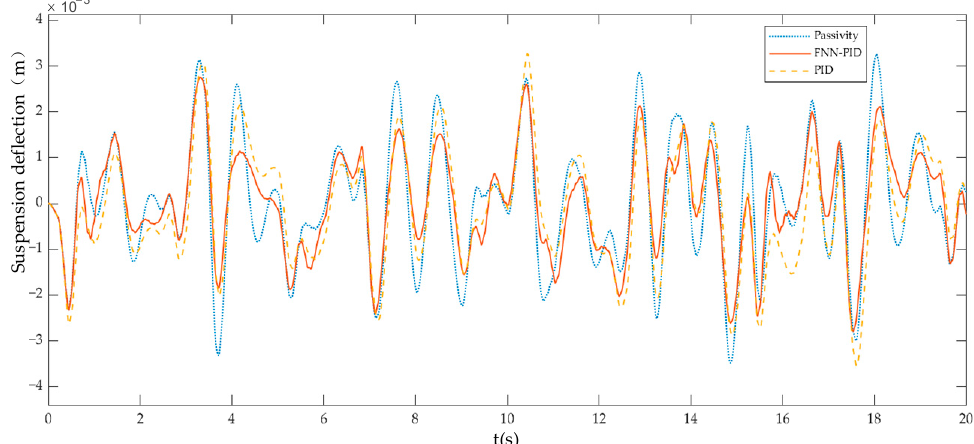
Figure 10. Comparison of Dynamic Deflection of Suspension simulation results.